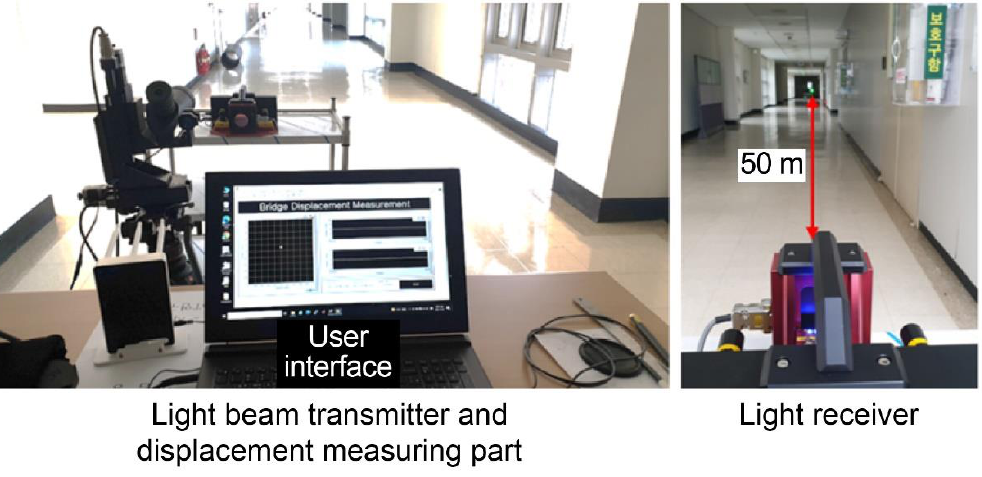
Figure 3. Lab-scale experiment setup for accuracy validation.